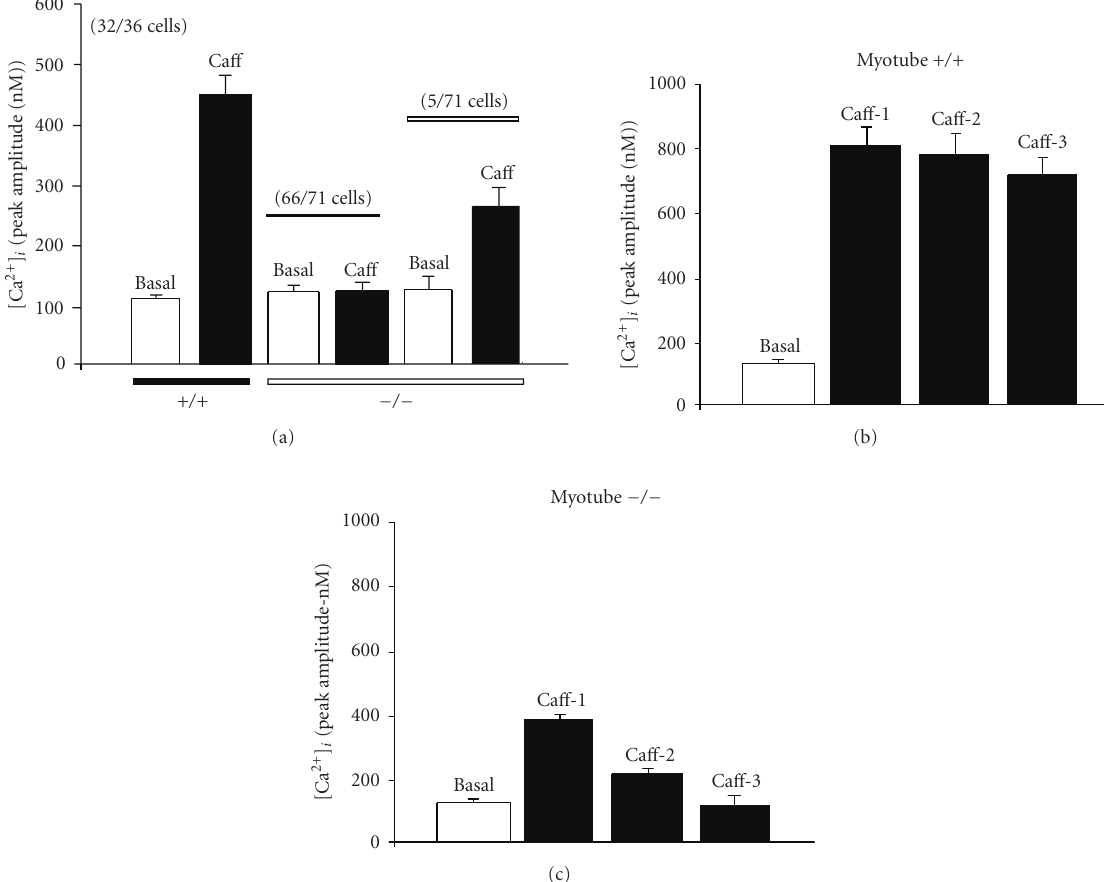
Figure 3: Peak amplitude of [Ca 2+ ] i response of myoblasts and myotubes to ca ff eine. Bar diagrams summarize the response of the cell types shown in Figure 2. (a) myoblasts (+/+ and − / − ): single application of 20 mM ca ff eine; (b) myotubes (+/+); (c) myotubes ( − / − ): 3 successive applications of 20mM ca ff eine. The number of cells pooled in a category and the total number of cells tested are given in brackets.